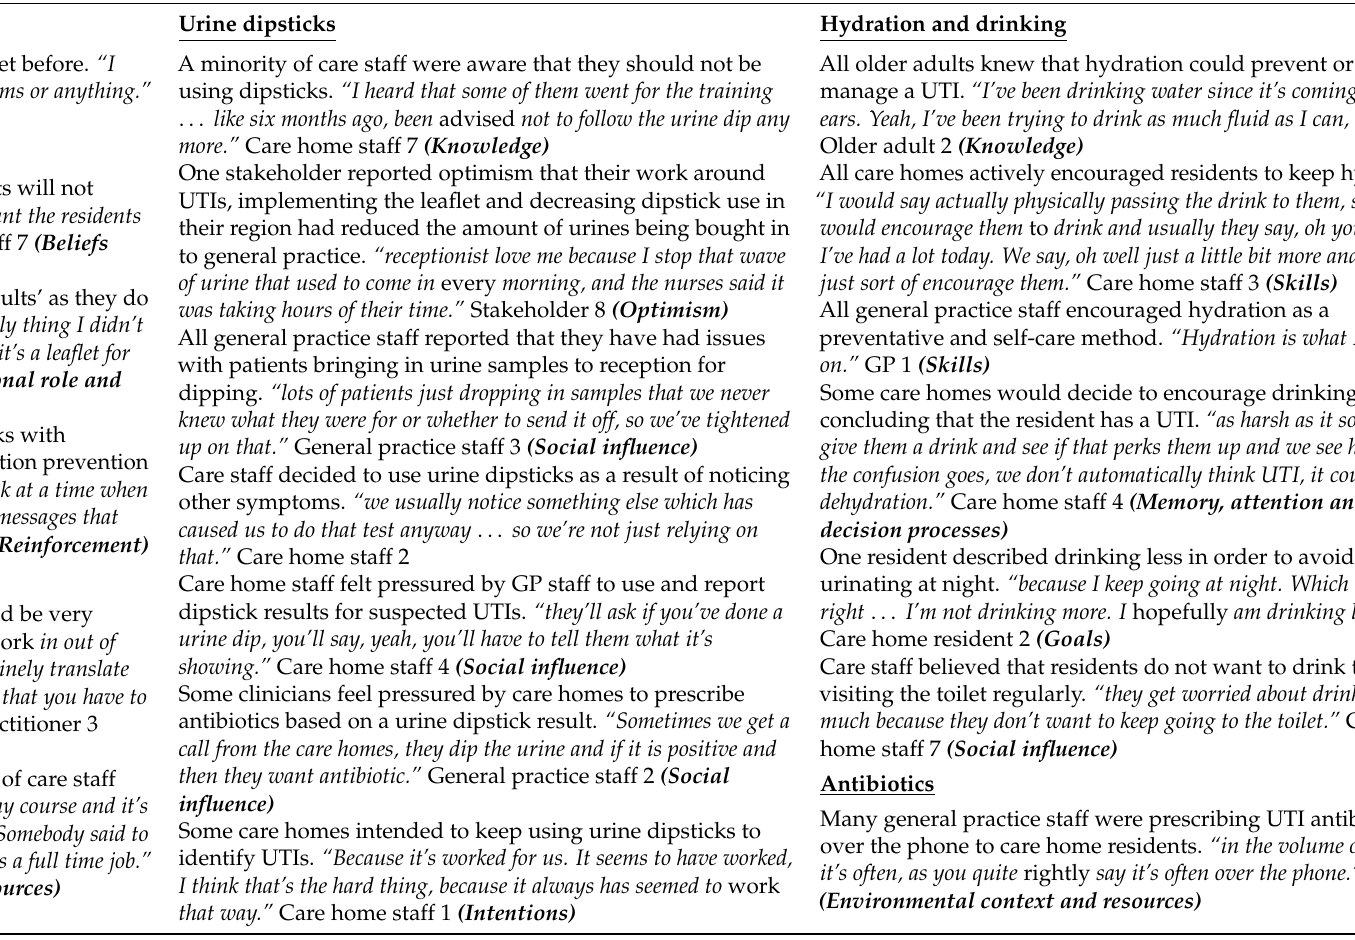
Table 1. Key findings and corresponding TDF domains covering use and implementation of the UTI leaflet, UTI diagnosis/identification and UTI management in older adults. Use and Implementation of the UTI